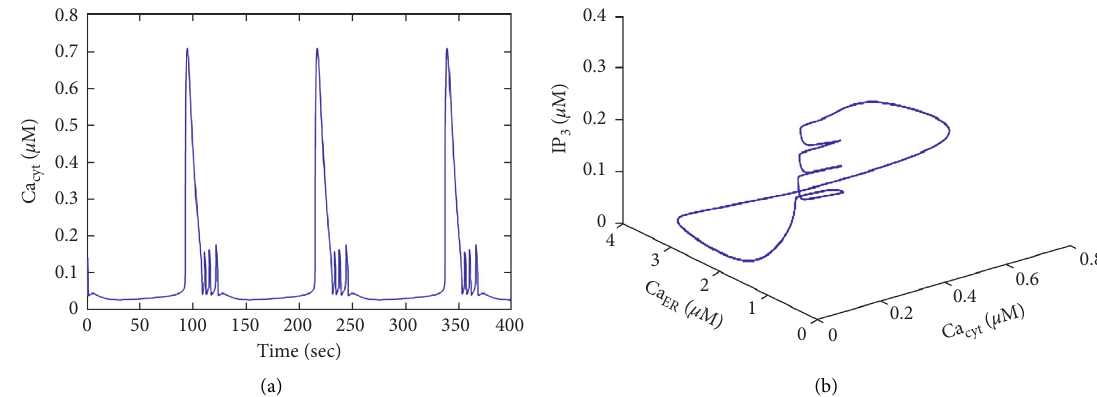
Figure 2: Time evolution of regular burst spontaneous Ca 2+ oscillations in astrocytes. (a) v � 0.045 μ ( x , y , z )-plane for v in